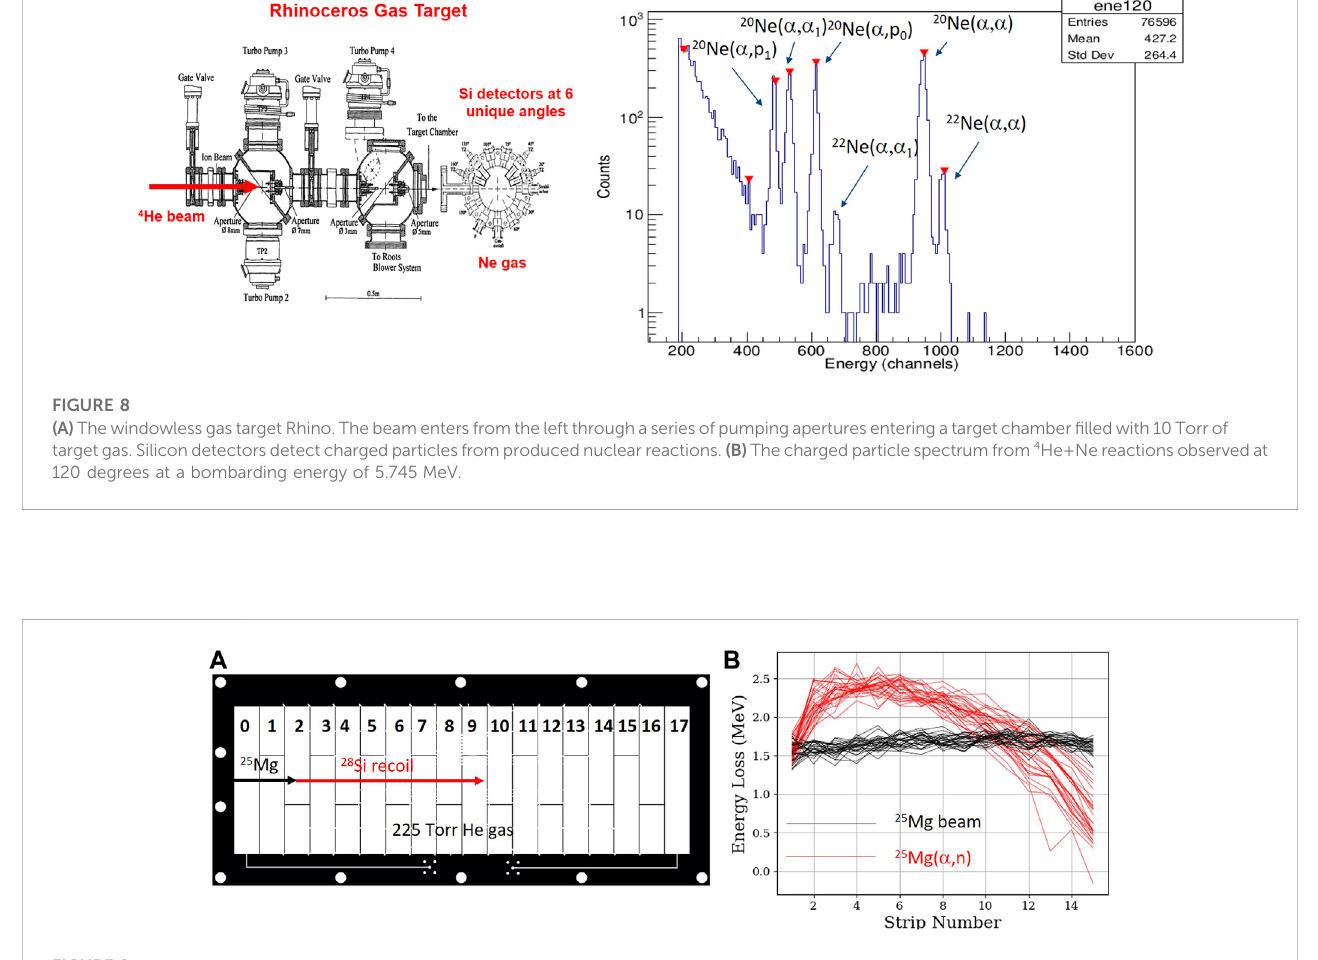
FIGURE 9 (A) The segmented anodeof the ATHENA active targetdetector. 25,26 Mg ions enter thechamber,and electrons liberated by their ionization are collected on the segmented anode. (B) A sudden increase in ionization is observed when an ( α , n ) reaction